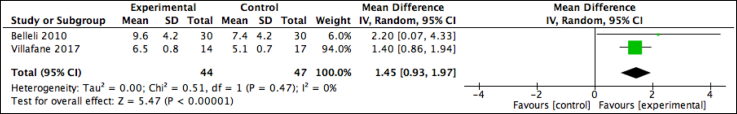
Pooled analysis for the Tinetti scale in patients with orthopedic conditions.